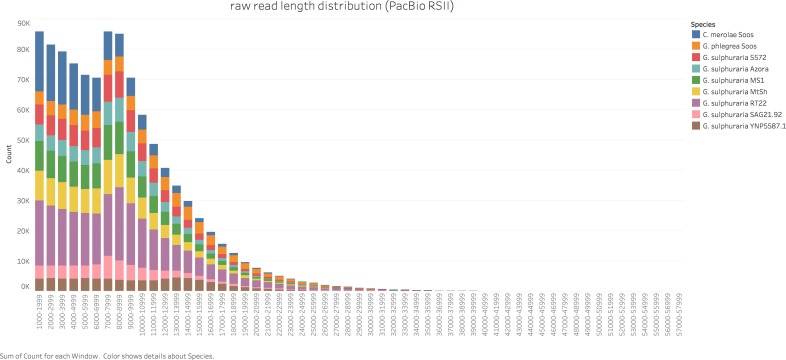
Raw read length distribution of the sequenced Cyanidiales strains.The strains were sequenced in 2016/2017 using PacBio’s RS2 sequencing technology and P6-C4 chemistry (the only exception being C. merolae Soos, which was sequenced as pilot study using P4-C2 chemistry in 2014). Seven strains, namely G. sulphuraria 5572, G. sulphuraria 002, G. sulphuraria SAG21.92, G. sulphuraria Azora, G. sulphuraria MtSh, G. sulphuraria RT22 and G. sulphuraria MS1 were sequenced at the University of Maryland Institute for Genome Sciences (Baltimore, USA). The remaining three strains, G. sulphuraria YNP5578.1, G. phlegrea Soos and C. merolae Soos, were sequenced at the Max-Planck-Institut für Pflanzenzüchtungsforschung (Cologne, Germany).